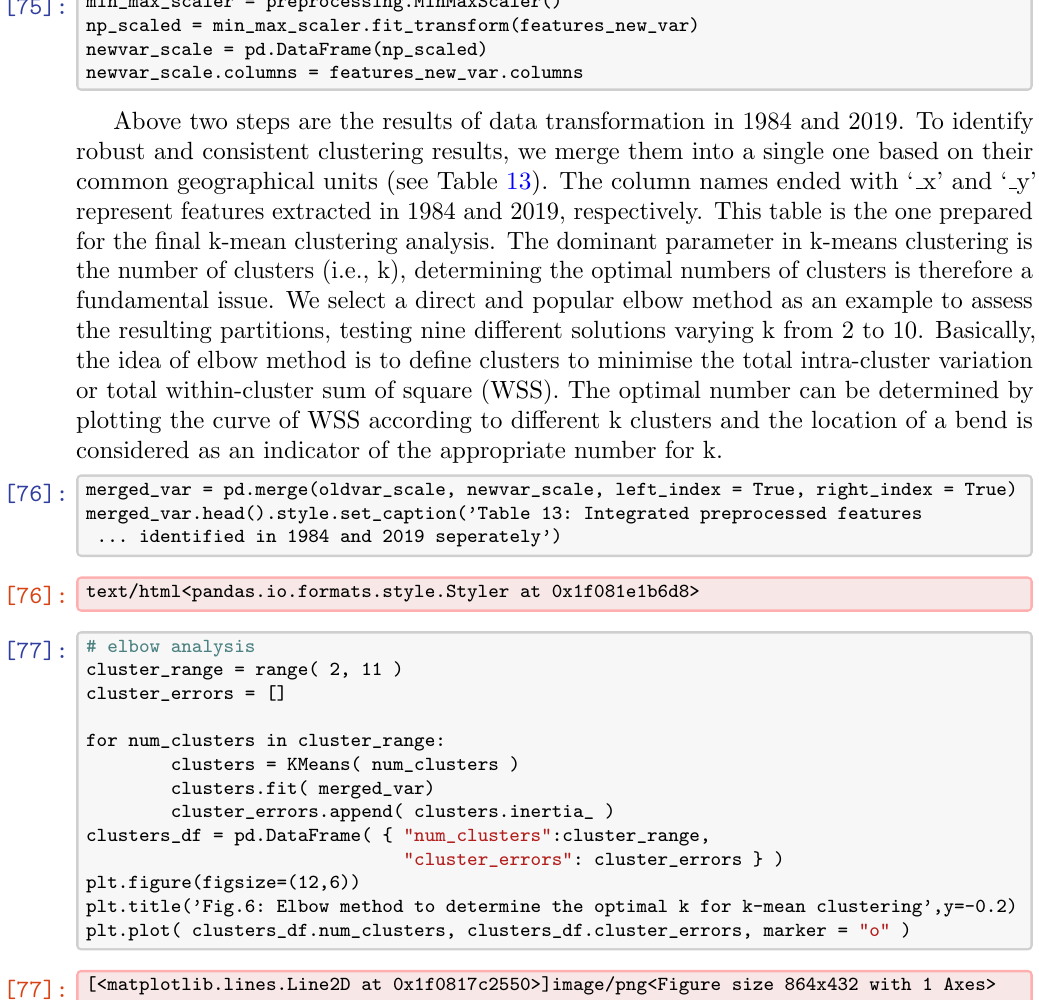
plt.figure(figsize=(12,6)) plt.title(’Fig.6: Elbow method to determine the optimal k for k-mean